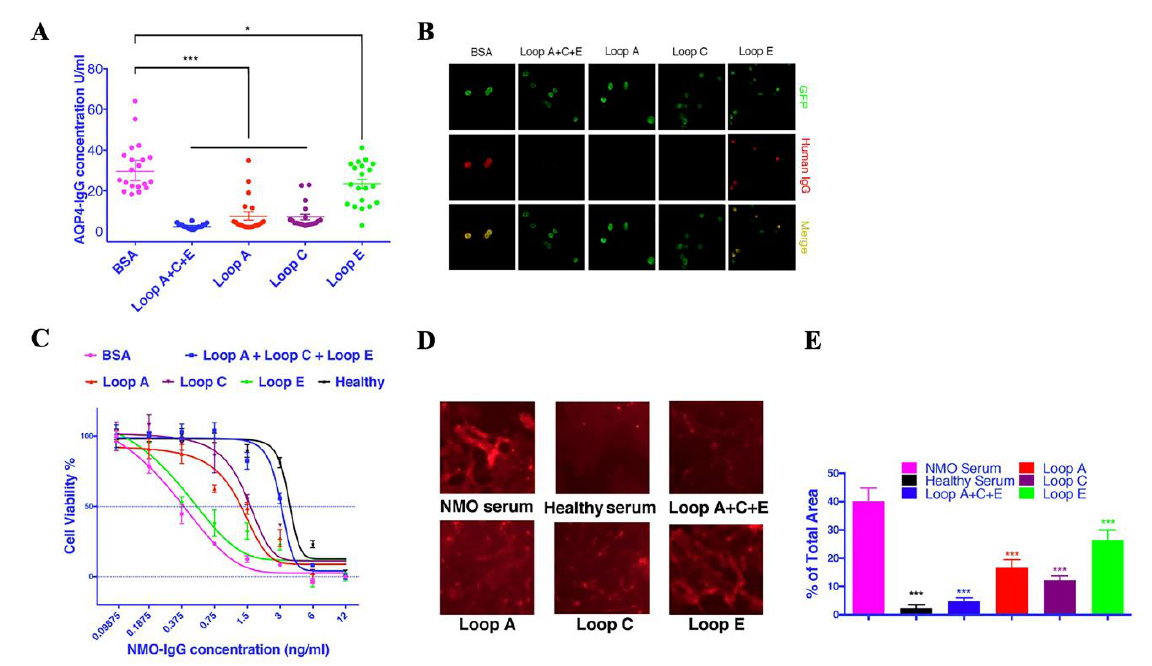
Figure 1. AQP4 extracellular mimotopes neutralized AQP4 autoantibodies. Additionally, different peptides interrupted the binding of AQP4-IgG to cultured astrocytes and reduced the complement-dependent cytotoxicity against astrocytes. ( A ) AQP4 extracellular mimotope peptides reduced the AQP4-IgG concentration detected by ELISA. * represents p < 0.05 when compared with the BSA group; *** represents p < 0.001 when compared with the BSA group. ( B ) AQP4 mimotope peptides interrupted the binding of AQP4-IgG to AQP4-GFP-transfected HEK293T cells. ( C ) AQP4 extracellular mimotope peptides reduced the complement-dependent cytotoxicity of AQP4-IgG against astrocytes. ( D ) Indirect immunofluorescence revealed that the human IgG-labeled area was reduced when patient serum was incubated with AQP4 extracellular mimotope peptides. ( E ) Relative human IgG immunofluorescence (Mean ± SEM); 4 wells per group. *** represents p < 0.001 when compared with the BSA group.